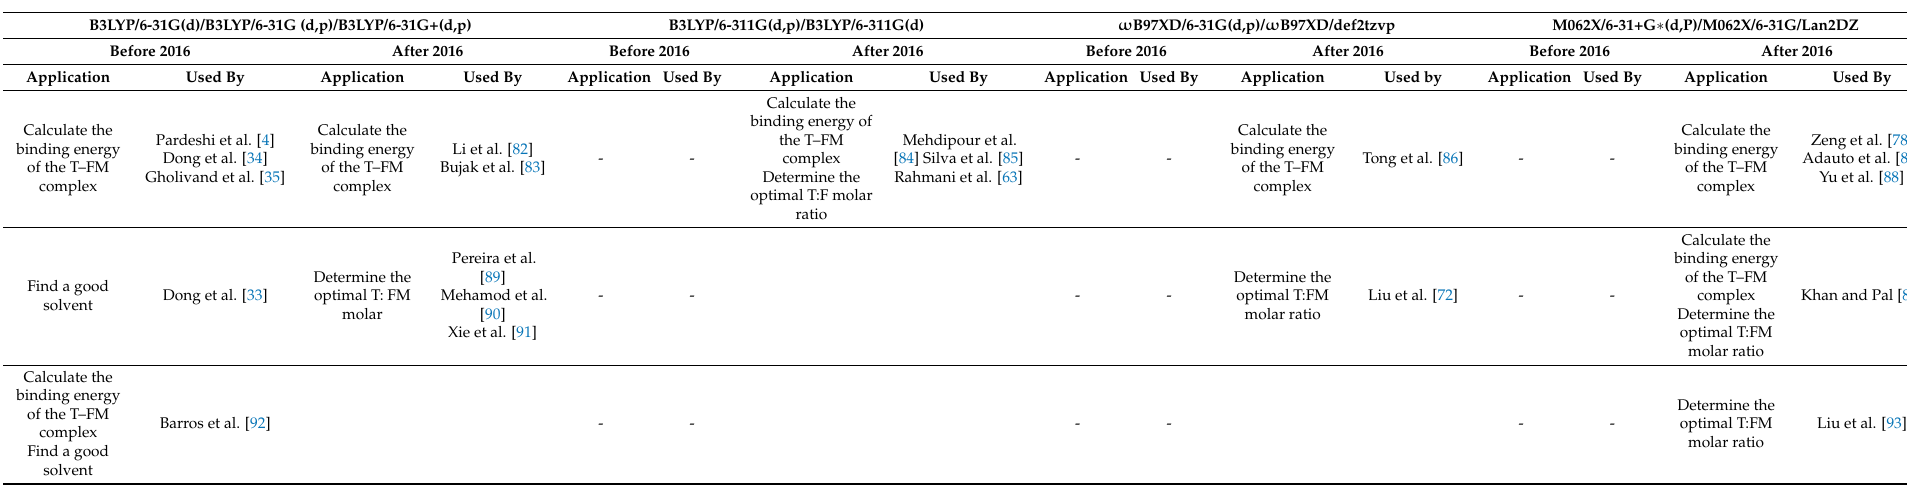
Table 5. Comparison of the density functional theory (DFT) approach to design molecularly imprinted polymers (MIPs) before and after